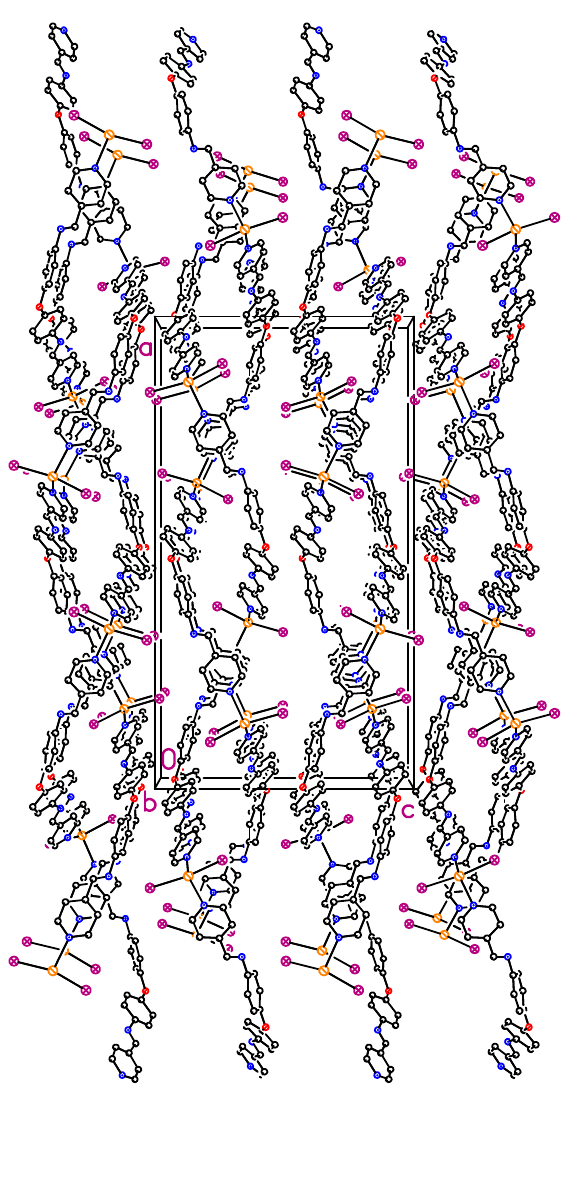
Figure 2. The polymeric double helix structure in 1. H atoms and solvent molecule are omitted for